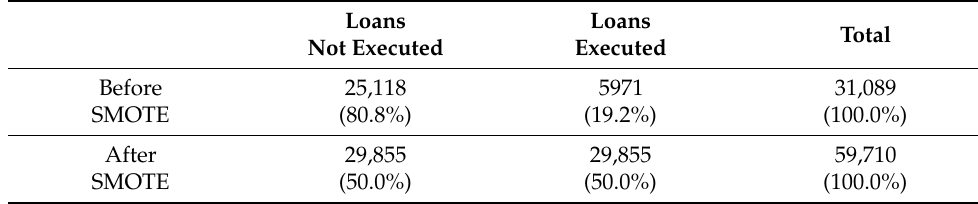
Table 4. Comparison before and after SMOTE technique to solve class imbalance